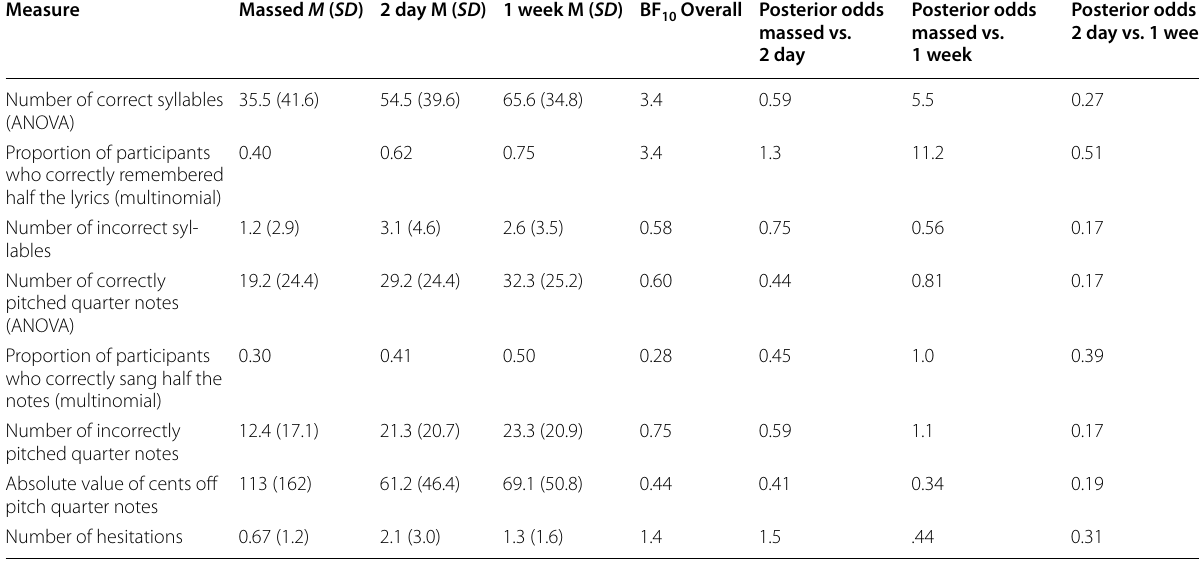
Table 3 Spacing effects at test 3.1